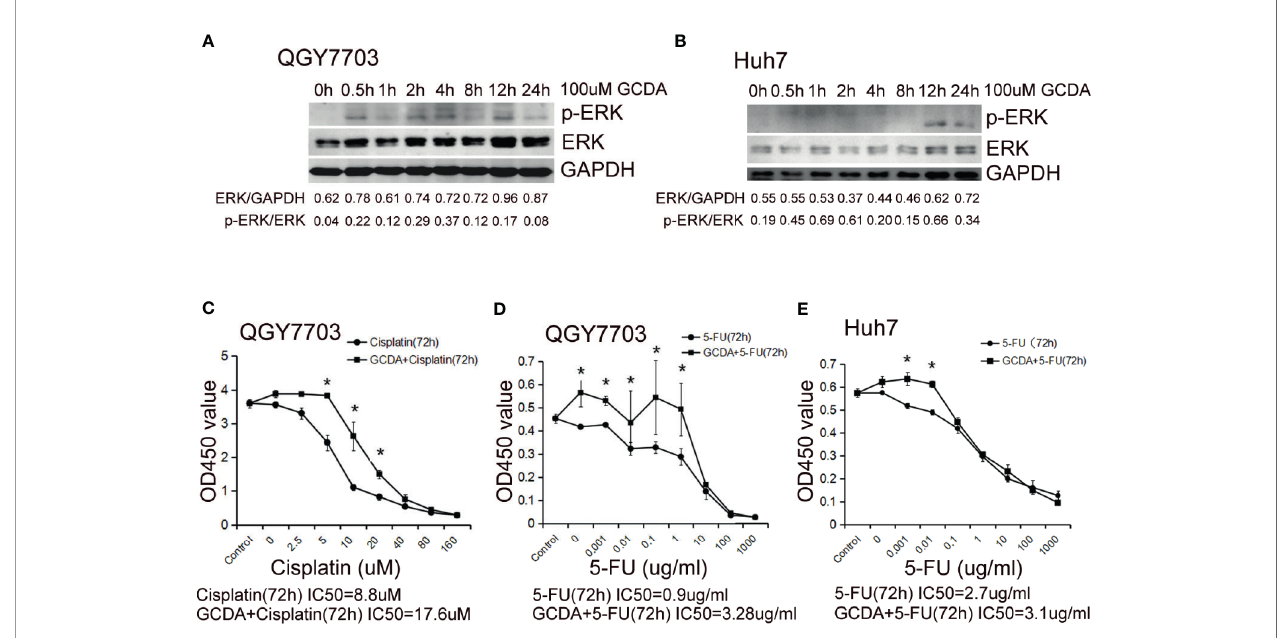
FIGURE 2 | GCDA induces ERK1/2 phosphorylation, which may be involved in prolonged survival of human liver cancer cells. (A, B) 100 m M GCDA was used to treat QGY7703 and Huh7 cells for 0h, 0.5h, 1h, 2h, 4h, 8h, 12h and 24h. The expression level of ERK1/2 and p-ERK1/2 were tested by western blot and quanti fi ed by Alphaview software. (C – E) Antitumor drug (Cisplatin or 5-FU) or GCDA (100 m M)+antitumor drug(Cisplatin or 5-FU) were used to treat QGY-7703 and Huh7 cells for 72h. CCK8 was performed to determine the viable cells. IC50 is calculated as the concentration of Cisplatin or 5-FU inducing a 50% reduction in cell viability. All data represent the mean±SD and were obtained from at least three independent experiments. *P < 0.05 (Student ’ s